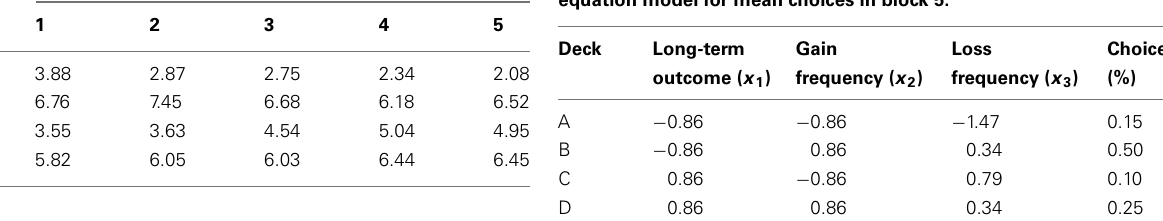
FIGURE 2 | Mean number of cards drawn from each deck of the Iowa GamblingTask over five consecutive blocks of 20 choices. Red lines indicate decks identified as disadvantageous in the original publication of the task. Solid lines identify decks with high gain frequency, broken lines those with low gain frequency. Bars represent SE of the mean (SE). Table 4 | Example (one subject’s) least-squares solution of the linear equation model for mean choices in block